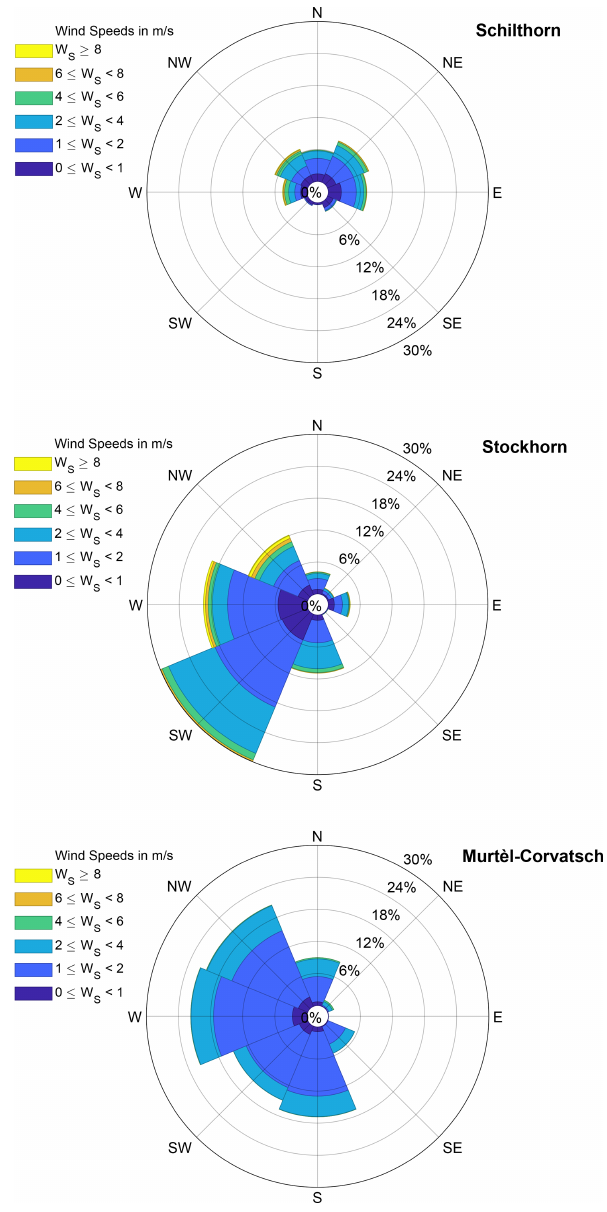
Figure 5. Wind speed and direction at all three stations aver- aged over the observation periods: Murtèl–Corvatsch (1997–2018), Schilthorn (1999–2018) and Stockhorn (2006–2018). Note that scales of relative frequencies are different in the different subplots.